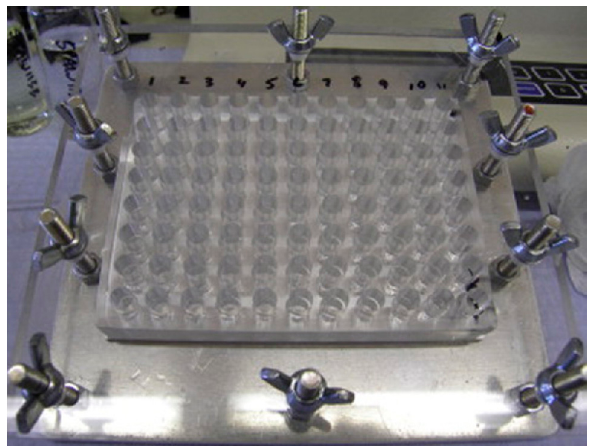
Figure 1. High-throughput corrosion inhibition rig consisting of a 10-mm-thick polycarbonate clamped to a 10-mm-thick block of polydimethylsiloxane rubber, an abraded plate of alloy, and a 5-mm-thick metal baseplate. The polycarbonate and polydimethylsiloxane sheets have an 8 × 11 grid of holes for test solutions 6 mm in diameter. Used with permission from Winkler et al. [1].